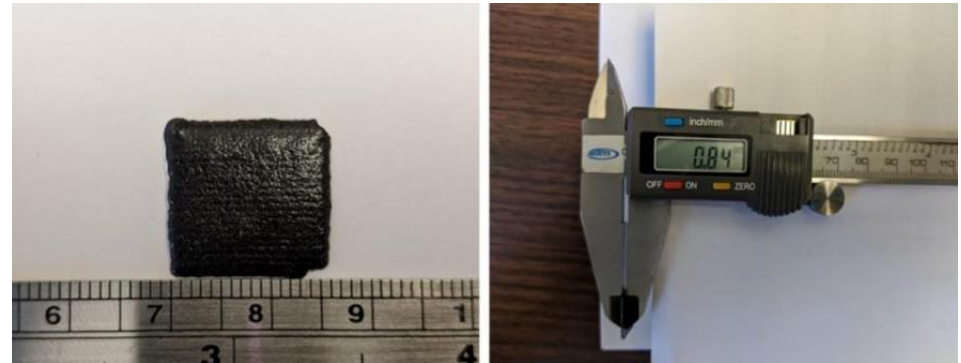
Figure 6. Appearance and dimensions of a single cured layer of 3D printed magnetic composite.